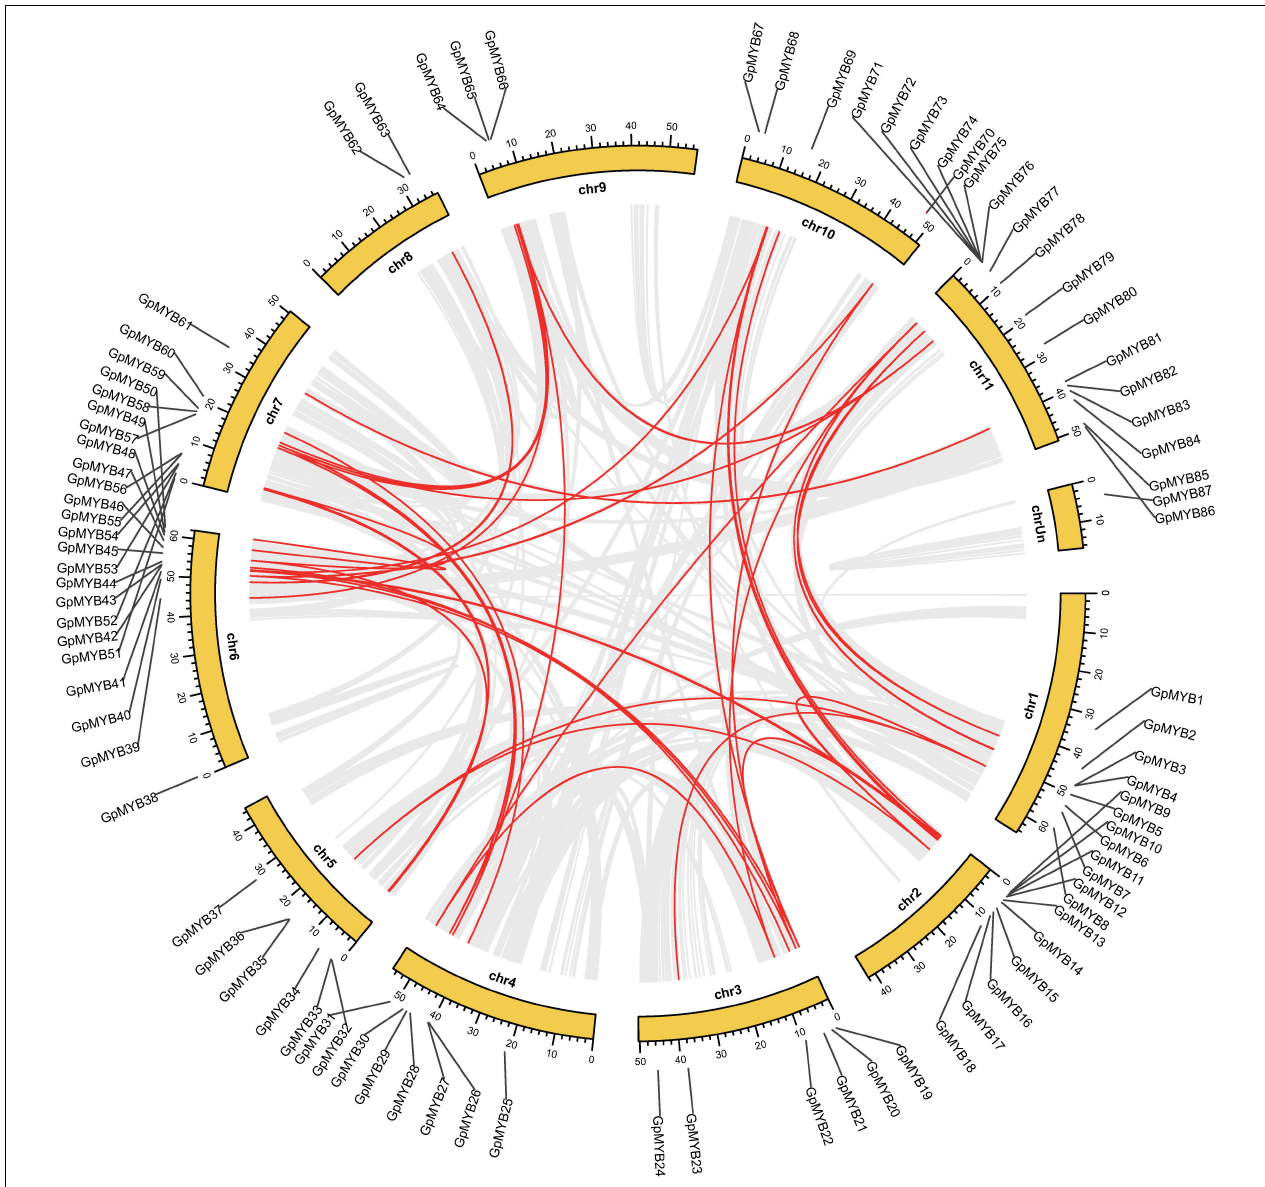
FIGURE 4 | Synteny analysis of G. pentaphyllum R2R3-MYB genes. Chr 1–11 represent chromosome-scale scaffolds and ChrUn indicates an unanchored linkage group. All the synteny gene pairs and duplicated MYB gene pairs were presented by gray lines and red lines,